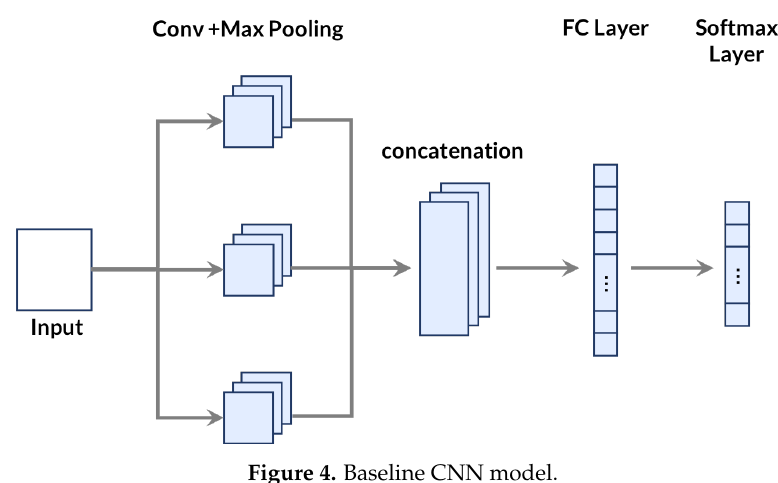
Figure 4. Baseline CNN model.